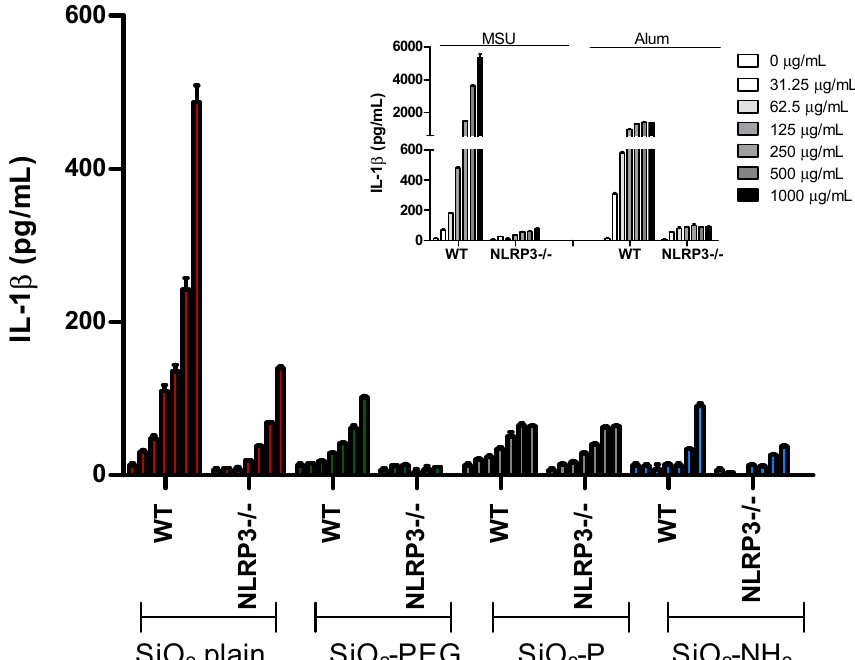
Figure 2. Surface modifications of silica nanoparticles diminish inflammasome activation. ELISA for IL-1 β from WT or NLRP3 − / − murine bone marrow-derived dendritic cells (BMDC) treated with increasing concentration (0–1000 µg/mL) of SiO 2 plain (red), SiO 2 -PEG (green), SiO 2 -P (gray), SiO 2 - NH 2 (blue). As control Alum or Monosodium Urate Crystals (MSU) were used (inset). Vivo